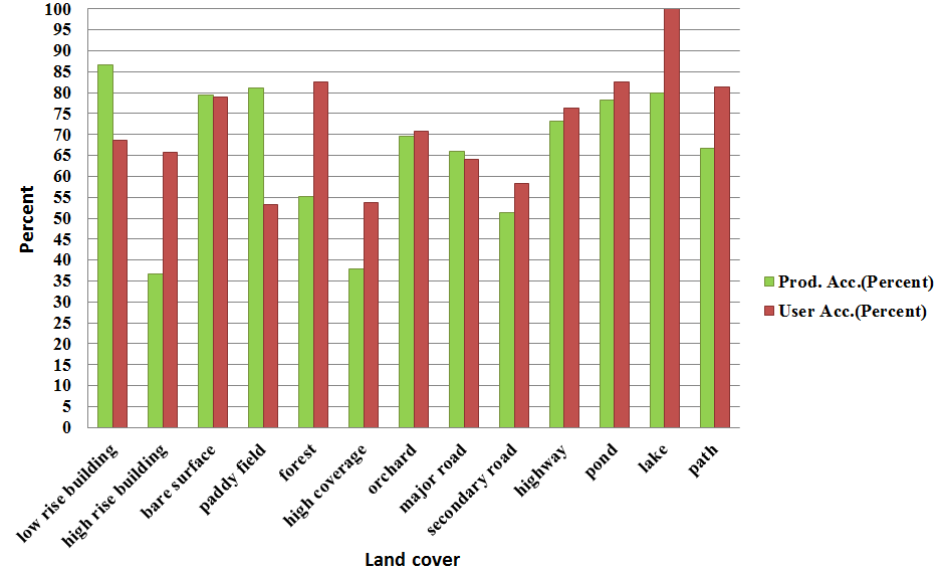
Figure 5. Comparison of land cover extraction results. Columns in green color represent the producer’s accuracy for land cover extraction, and columns in red color represent the user’s accuracy.